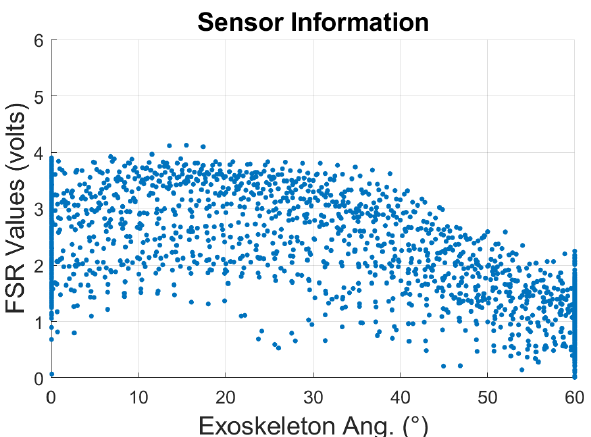
Figure 8. Scatter plot of the exoskeleton input values and FSR values for a subject during elbow flexion–extension multiple cycles.